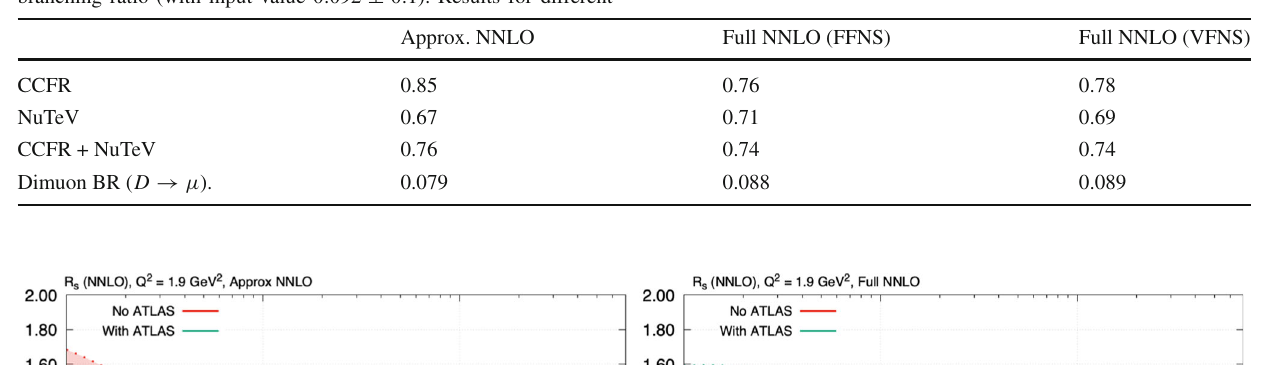
theoretical treatments are given; full NNLO (VFNS) corresponds to the default MSHT fit